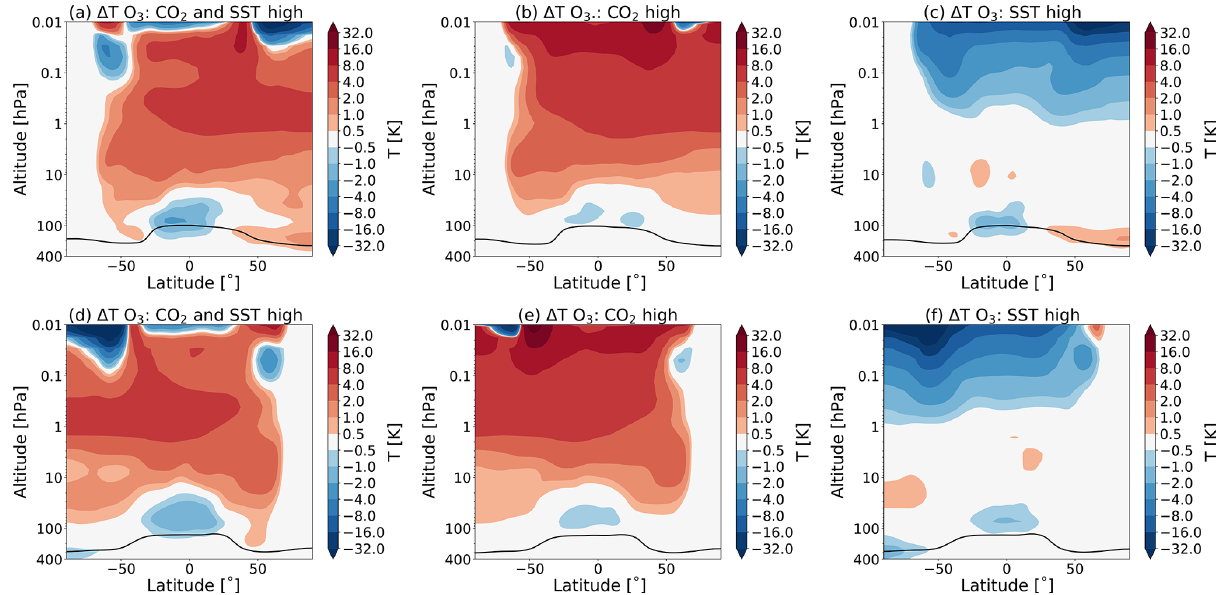
Figure 5. Partial temperature responses to changes in O 3 concentration, as calculated by CFRAM, in July (a–c) and January (d–f) due to (a, d) the combined effect of the CO 2 increase and SST changes (experiment S3), (b, e) the doubling of the atmospheric CO 2 concentration (experiment S1) and the (c, f) SSTs (experiment S2). The tropopause height is indicated as in Fig. 1.